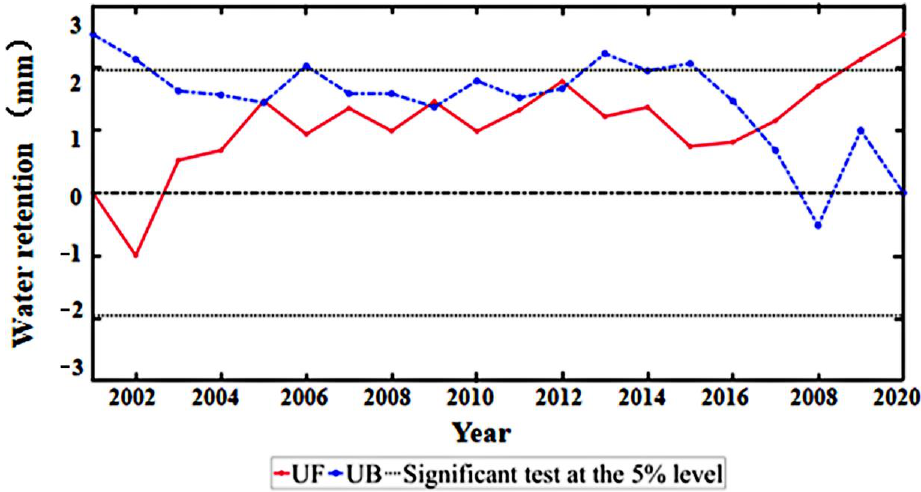
Figure 4. The trend of water retention mean value change in the HYR from 2001 to 2020. The Y axis represents the statistical sequence of water yield calculated at time X, which includes time series UF and inverse time series UB, and x refers to the years 2001 – 2020.